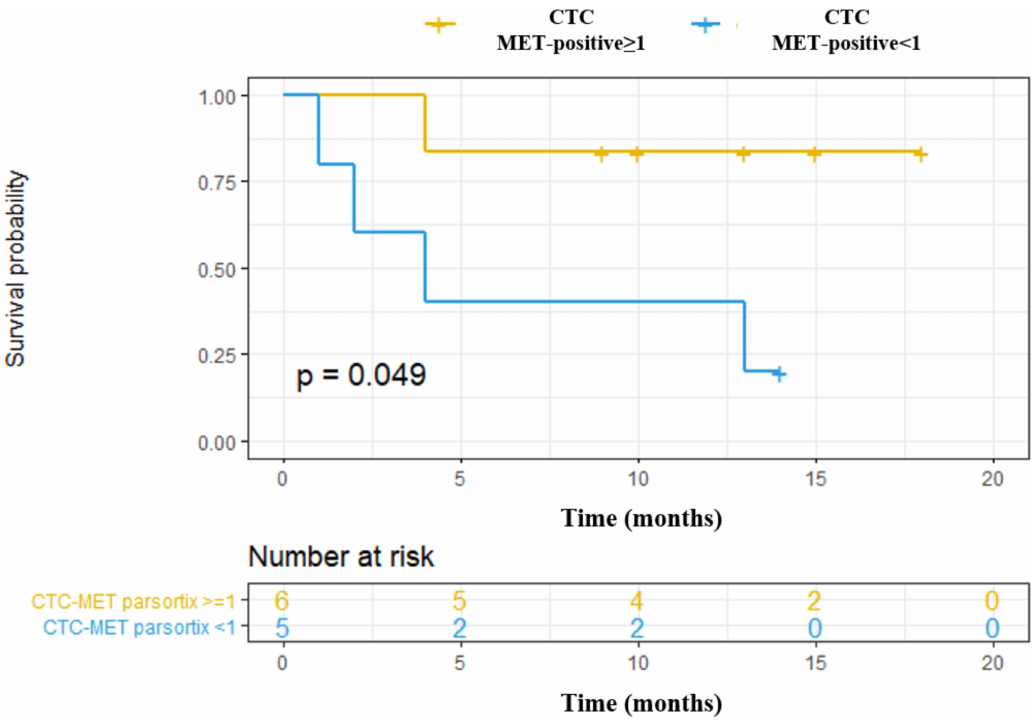
Figure 7. Prognostic value to predict Overall Survival (OS) of CTCs enumeration and MET expression in head and neck cancer patients starting with anti-EGFR treatment. CTCs MET-positive ≥ 1: CTCs with high MET expression (scores 2 + or 3 + ); CTCs MET-positive < 1: CTC with low MET expression (score 1 +